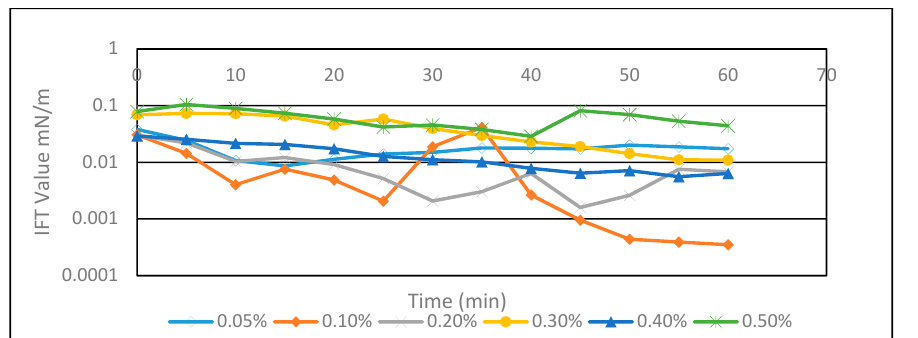
Figure 2. Crude oil-seawater IFT results for 0.05–0.5 wt.% of as-synthesized surfactant in seawater as published in [7].